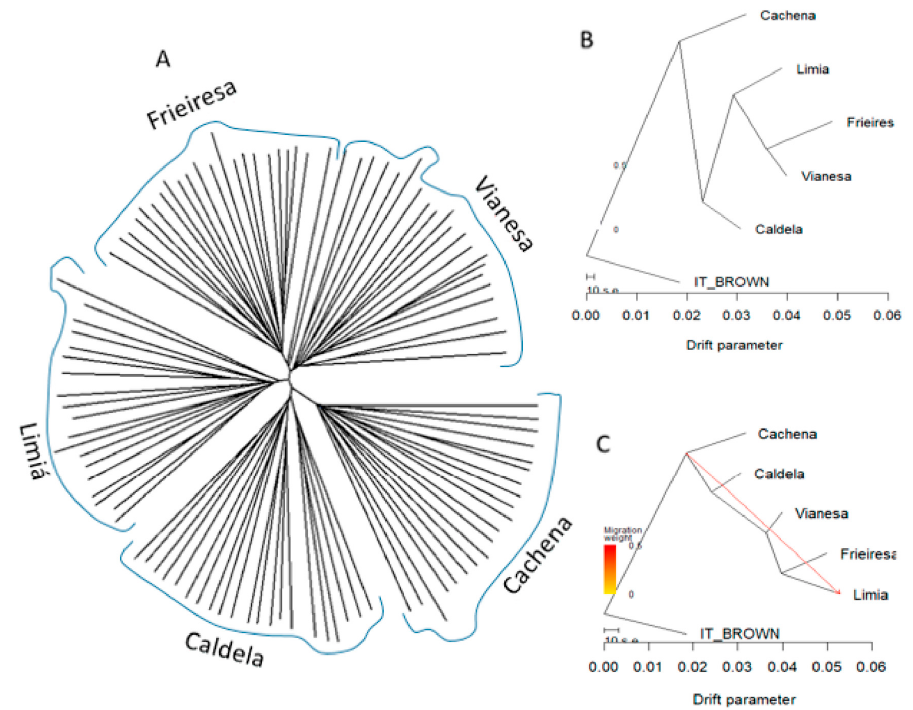
Figure 4. ( A ) Allele distance sharing dendrogram among Morenas Gallegas samples. ( B ) Maximum likelihood phylogenetic tree inferred using TreeMix with no migration rate and ( C ) with 1 migration edge allowed. Italian Brown Swiss (IT_BROWN) was used as outgroup in B and C